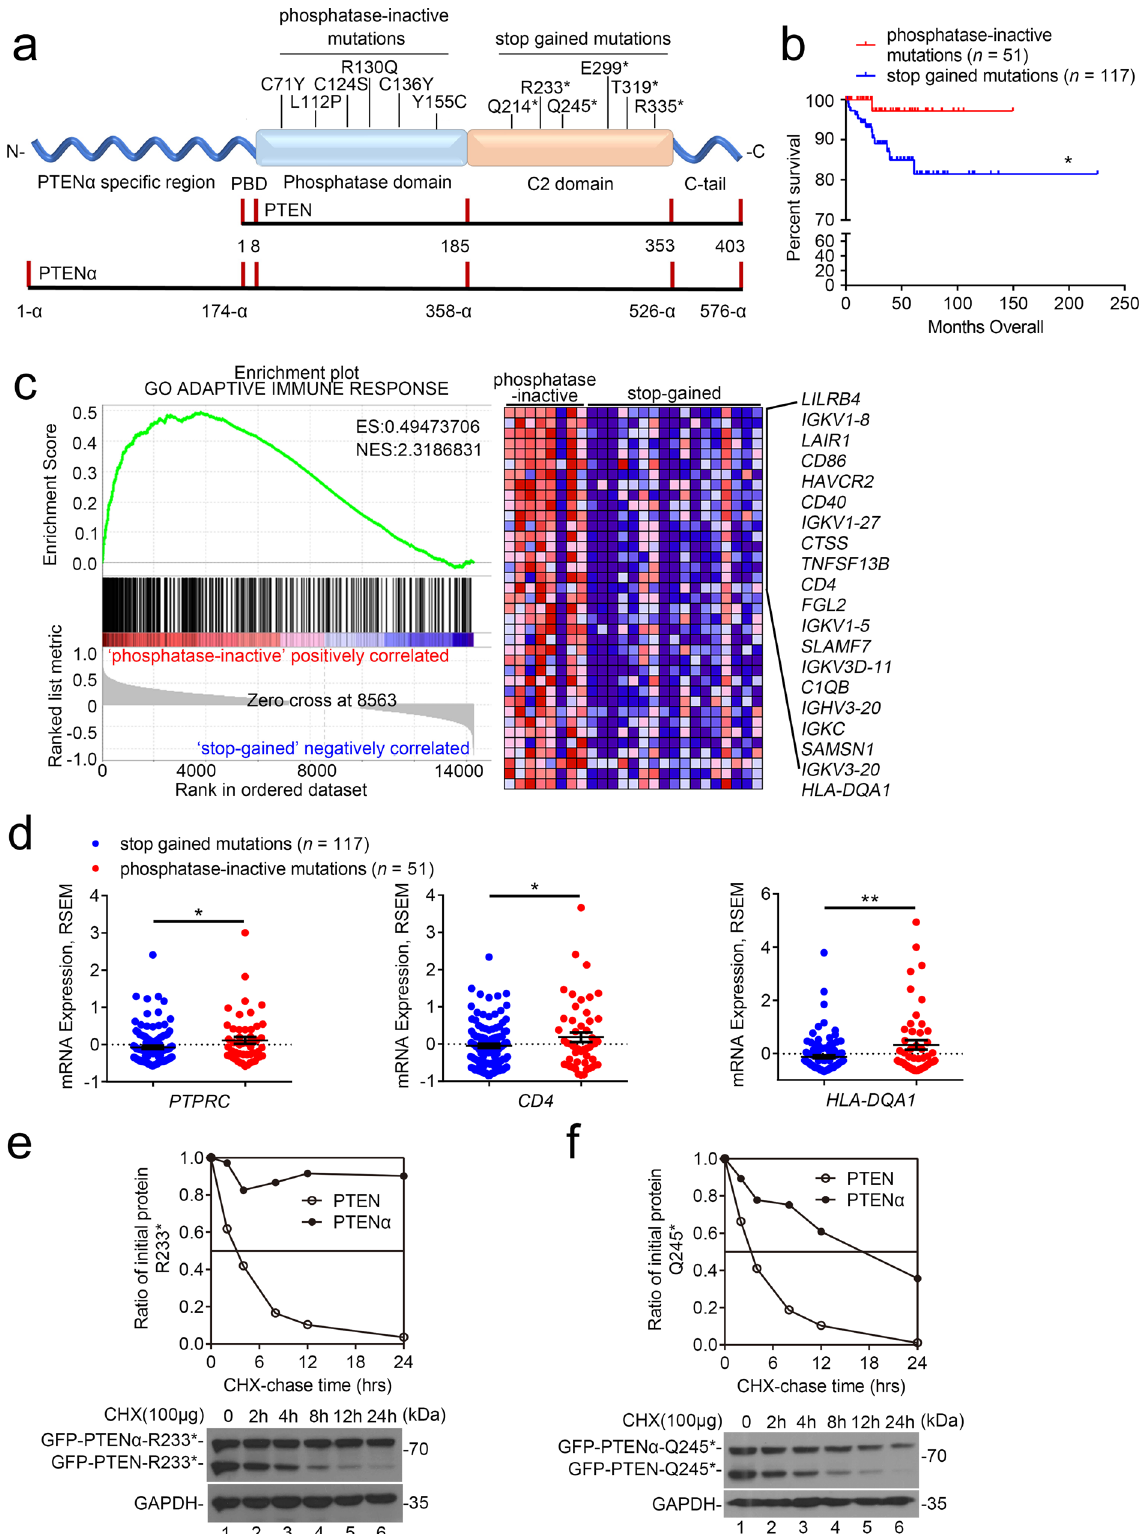
including CD4 + T, CD8 + T, Treg, NK, monocyte, macrophages, conventional DCs (cDCs). Compared with more than 80% of lymphoid cells in the control tumor, the percentage of